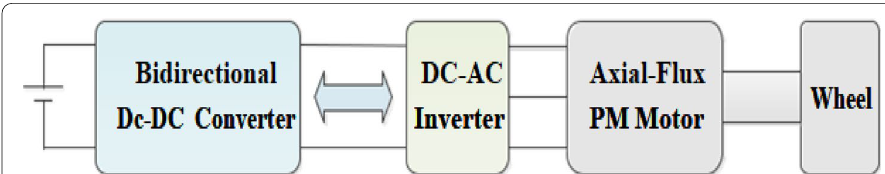
Fig. 2 The bidirectional DC-DC converter in EV powertrains